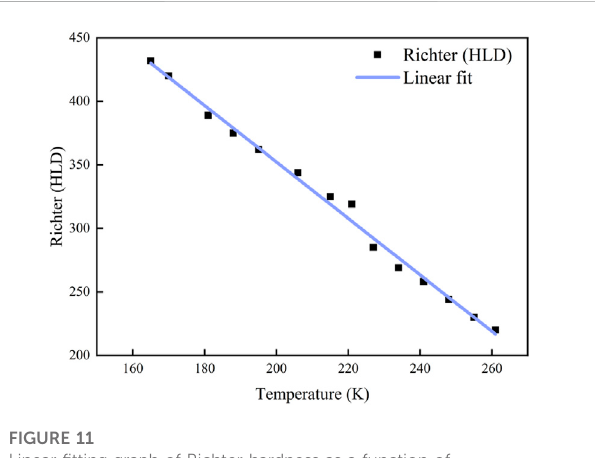
FIGURE 11 Linear fi tting graph of Richter hardness as a function of